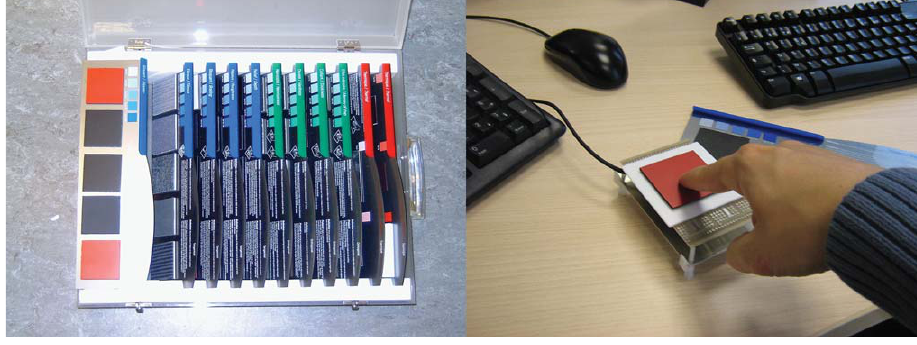
Fig. 1. Left: Sensotact, Right: Measurement setup for capturing contact forces during subjects’ exploration.